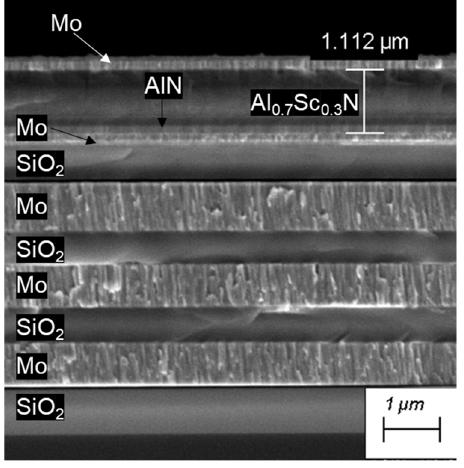
Figure 5. Cross ‐ sectional SEM micrograph of the SMR stack. Figure 5. Cross-sectional SEM micrograph of the SMR stack.